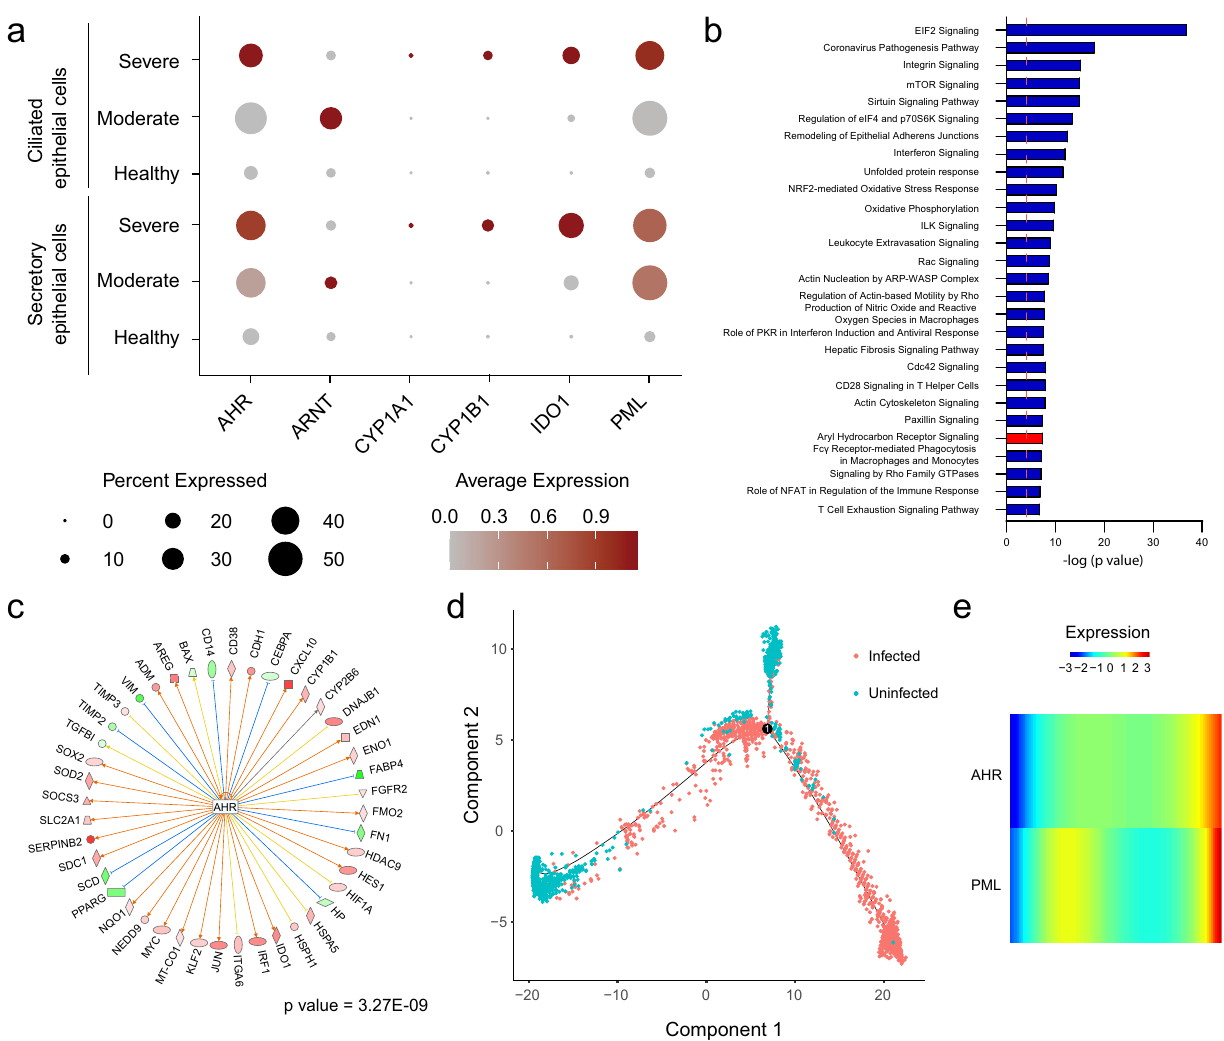
Fig. 4 scRNA-Seq on BALF epithelial cells identi fi ed activation of AHR signaling in COVID-19 patients. a AHR , ARNT , CYP1A1, CYP1B1, IDO1, and PML mRNA expression levels were determined by scRNA-Seq in ciliated and secretory epithelial cells from healthy or COVID-19 patients. b Ingenuity pathway analysis comparing uninfected to SARS-CoV-2 infected secretory epithelial cells. Dashed red line indicates p = 0.05. p values were determined using a right-tailed Fisher ’ s exact test. c Upstream regulator analysis on infected secretory epithelial cells identi fi ed AHR as a signi fi cant transcriptional regulator in the response of secretory epithelial cells to SARS-CoV-2 infection. p value was determined using a right-tailed Fisher ’ s exact test. d Cell fate trajectory analysis e Pseudo-time analysis of AHR and PML expression in infected